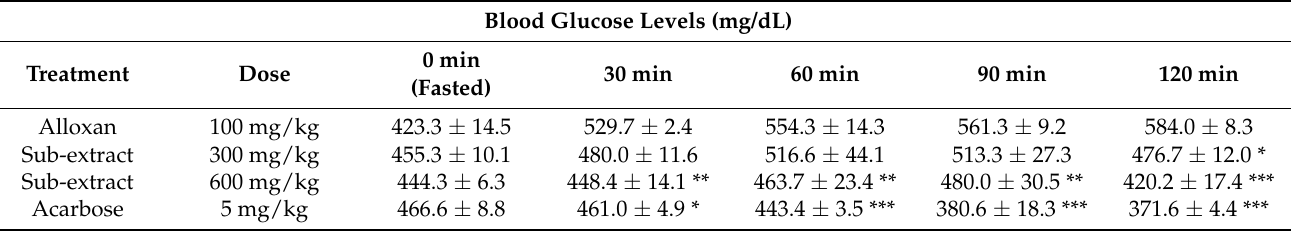
Table 4. Blood glucose levels of TFE (300 mg/kg), TFE (600 mg/kg) and acarbose (5 mg/kg)-treated rats in the alloxan-induced diabetic rats and healthy rats in the OGTT. Blood Glucose Levels (mg/dL)